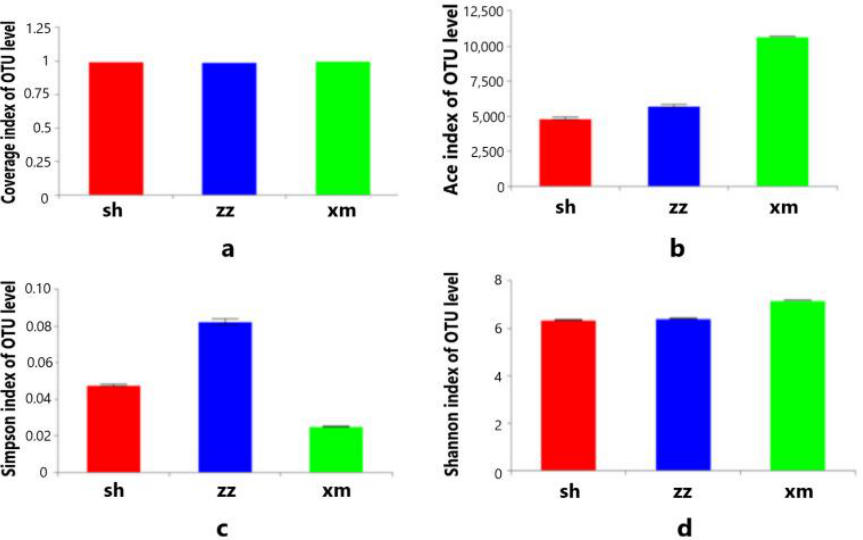
Figure 5. Average of Coverage ( a ), Ace ( b ), Simpson index ( c ), and Shannon index ( d ) of the aerosols in the three cities (sh: Shanghai; xm: Xiamen; zz: